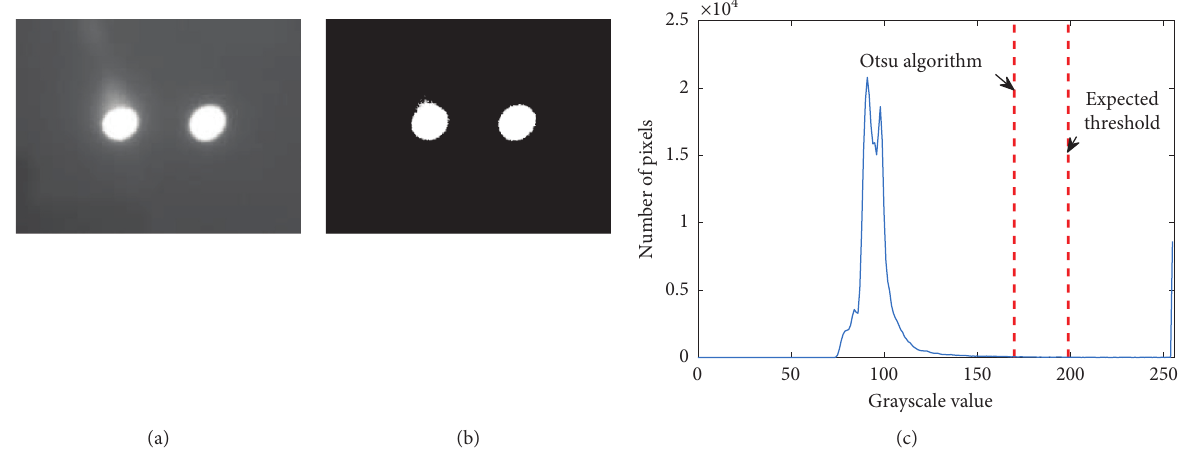
Figure 6: Otsu segmentation: (a) original image, (b) Otsu division, and (c) image